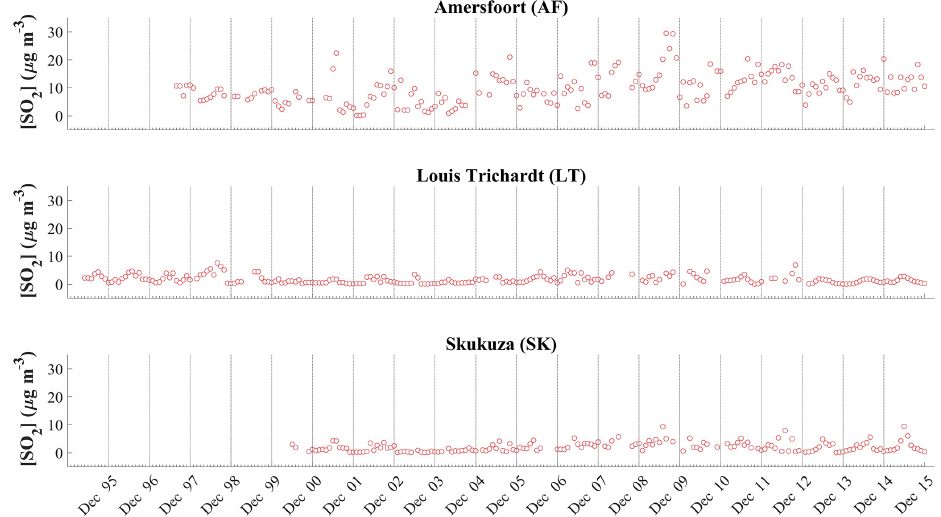
Figure A1. Time series of monthly average SO 2 concentrations measured at Amersfoort (AF), Louis Trichardt (LT) and Skukuza (SK) using passive samplers over the relevant measurement periods.